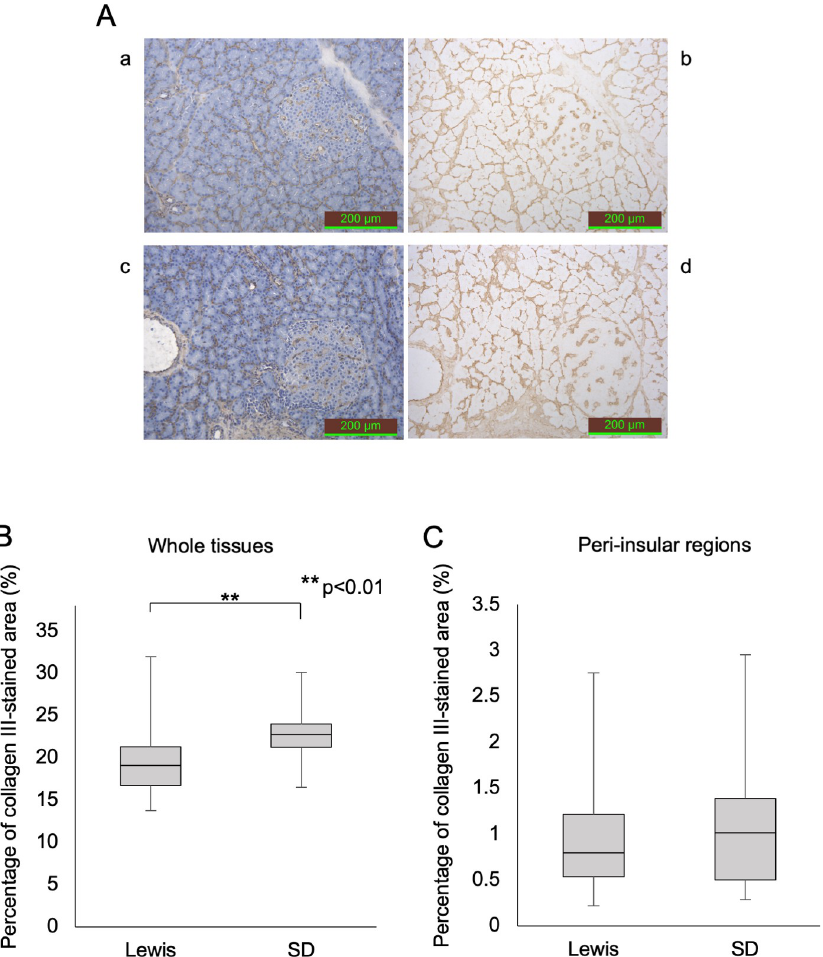
Fig 2. Anti-collagen III staining of the pancreatic tissues in each rat strain. (A) Anti-collagen III staining (a and b: Lewis rat; c and d: SD rat). The stained area was calculated using pictures without hematoxylin staining (b, d). (B) The percentage of the over-all anti-collagen III-stained area. (C) The percentage of the anti-collagen III-stained area in the peri-insular region only.